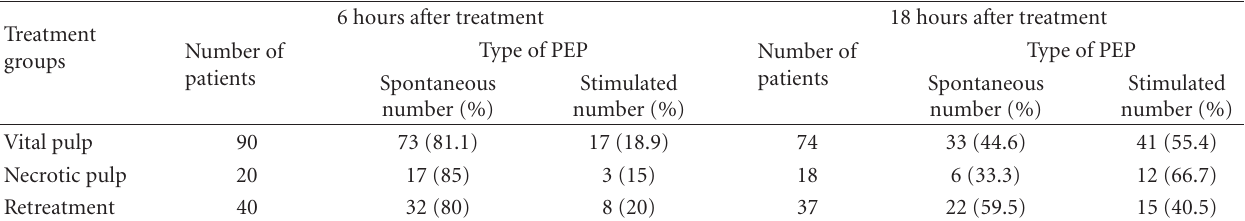
Table 3: Distribution of type of postoperative pain (PEP) after 6 and 18 hours in relation to the di ff erent treatment groups.